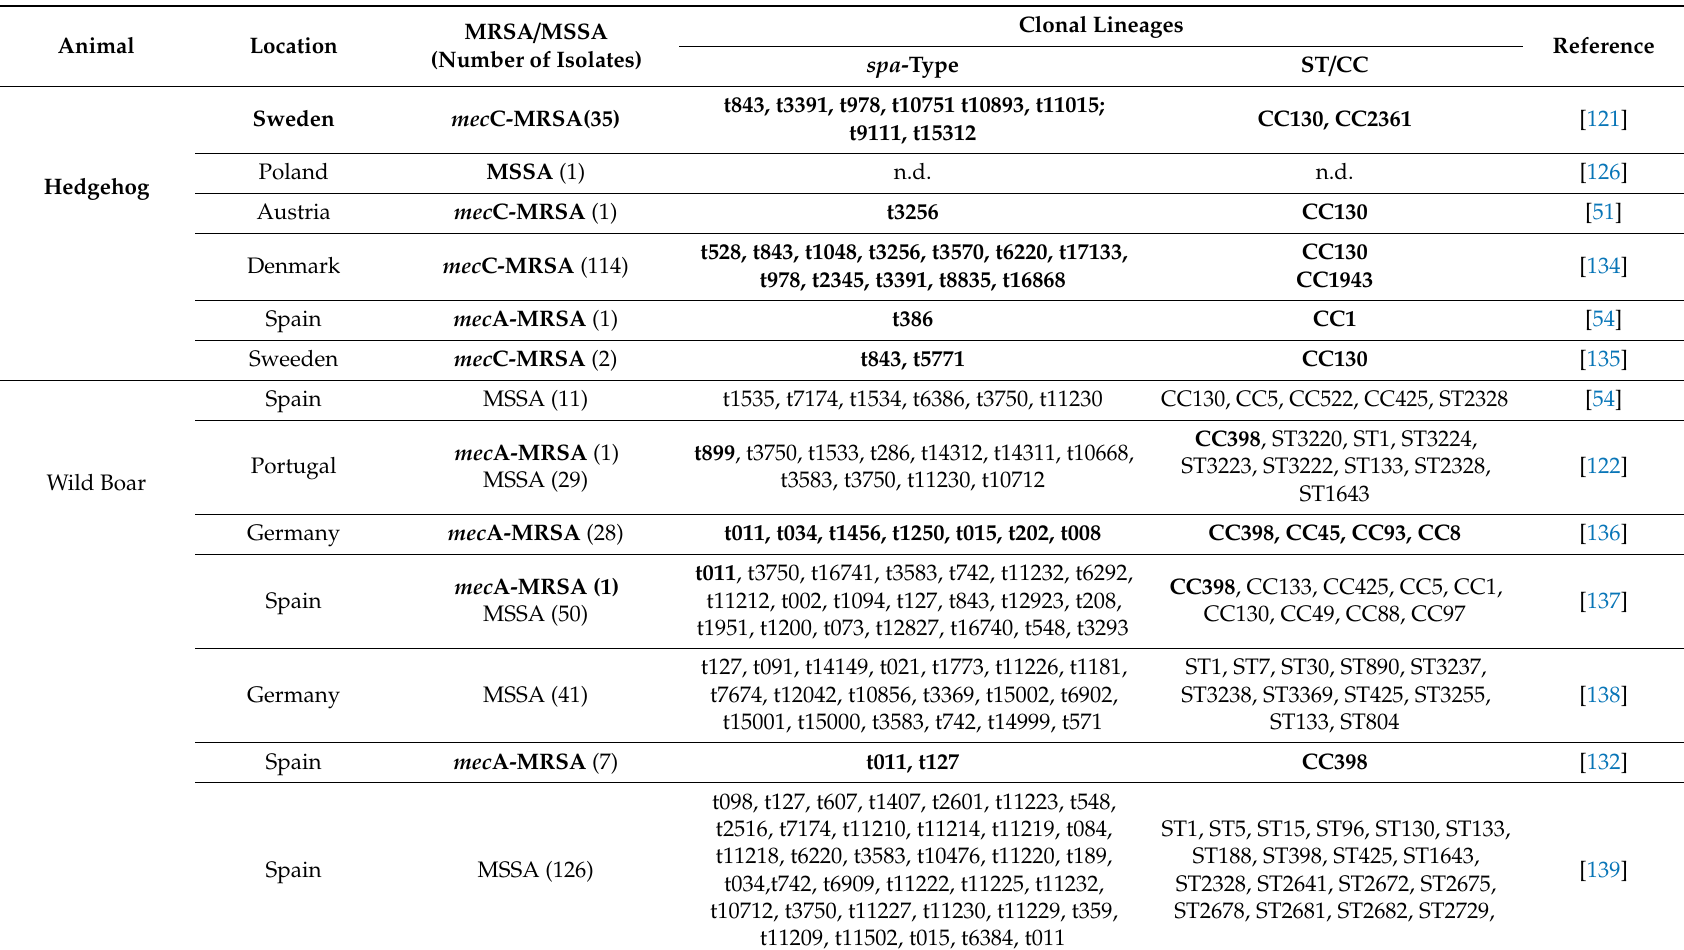
Table 2. Animal species, location of isolation and genetic lineages of S. aureus and MRSA isolated from European wild animals.